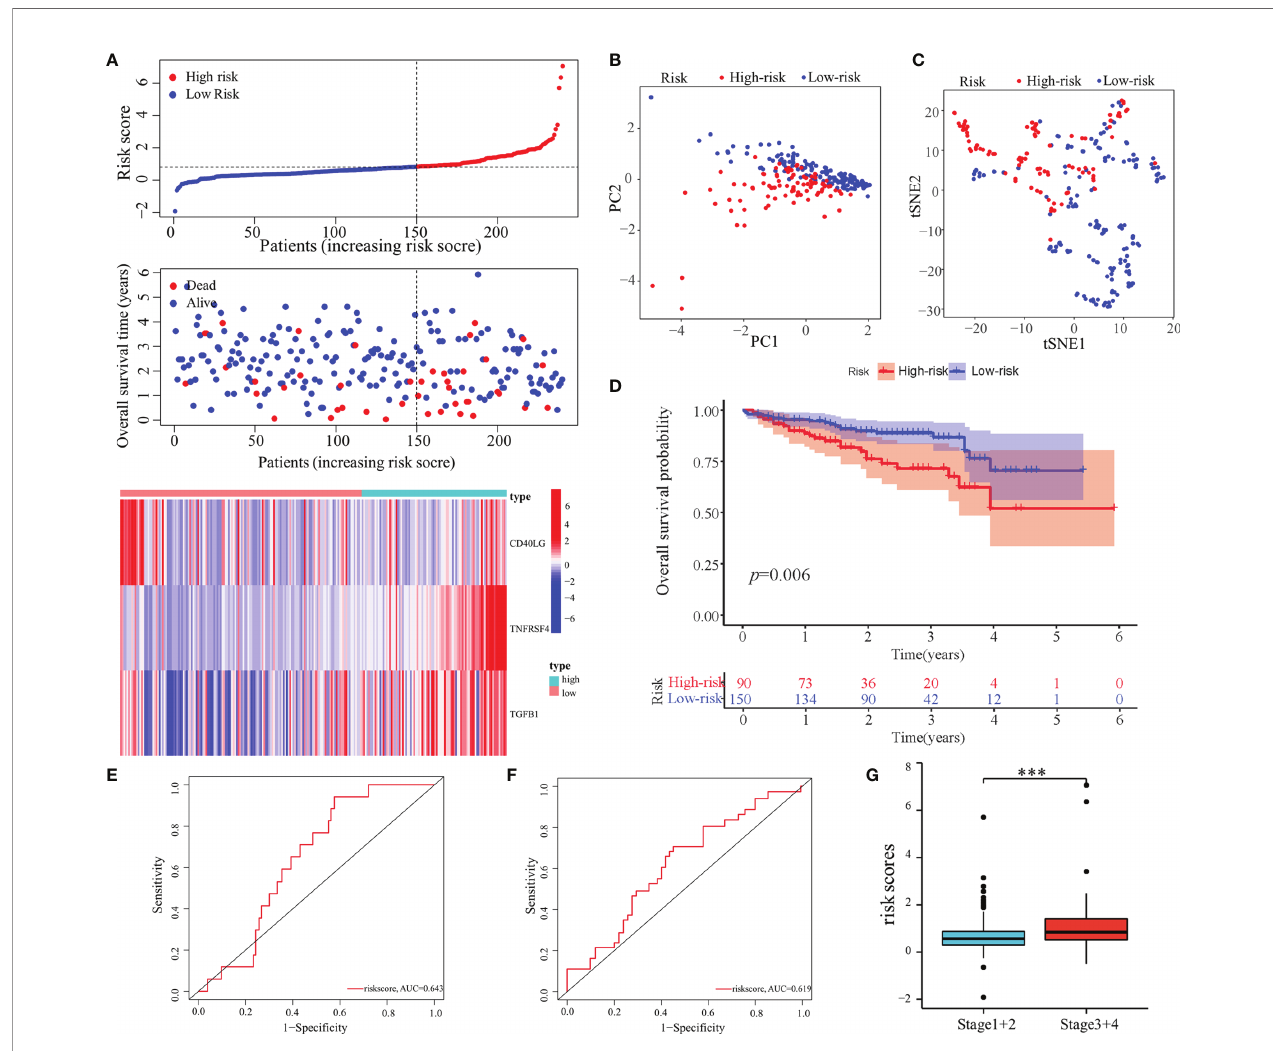
FIGURE 5 | Validation of the predictive model in the ICGC cohort. (A) Risk score, survival status, and expression of MED8-related immunomodulators in high-risk and low-risk groups of ICGC cohort. (B) PCA analysis of ICGC cohort. (C) t-SNE analysis of ICGC cohort. (D) Overall survival analysis in high-risk and low-risk groups of ICGC cohort. (E, F) ROC analyses of 1- (E) and 3-years (F) overall survival in the ICGC cohort. (G) Distribution of risk scores in different pathological stage of the ICGC cohort. ***: P <